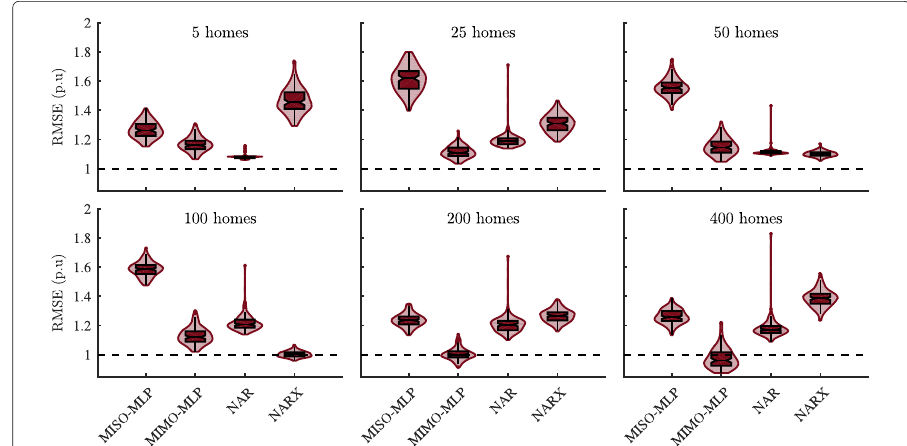
Fig. 4 RMSE relative to the error obtained with SLP when predicting load aggregations of different size. Boxplots and violin plots represent the variation of the obtained error. The boxplot notch denotes the confidence interval ( p -value 0.05). Violins depict a kernel density estimate of the error distribution (Hintze and Nelson 1998). Absolute error values are denoted in Table 3. All models had a substantial variation due to the random weight initializations and none was consistently better for all aggregations. Only for the biggest load (400 homes) was MIMO-MLP significantly more accurate than the SLP